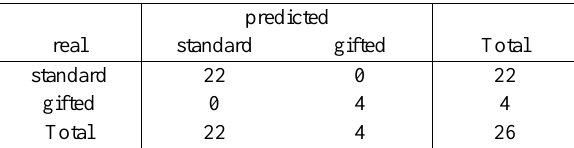
Table 7 Discriminant analysis prediction